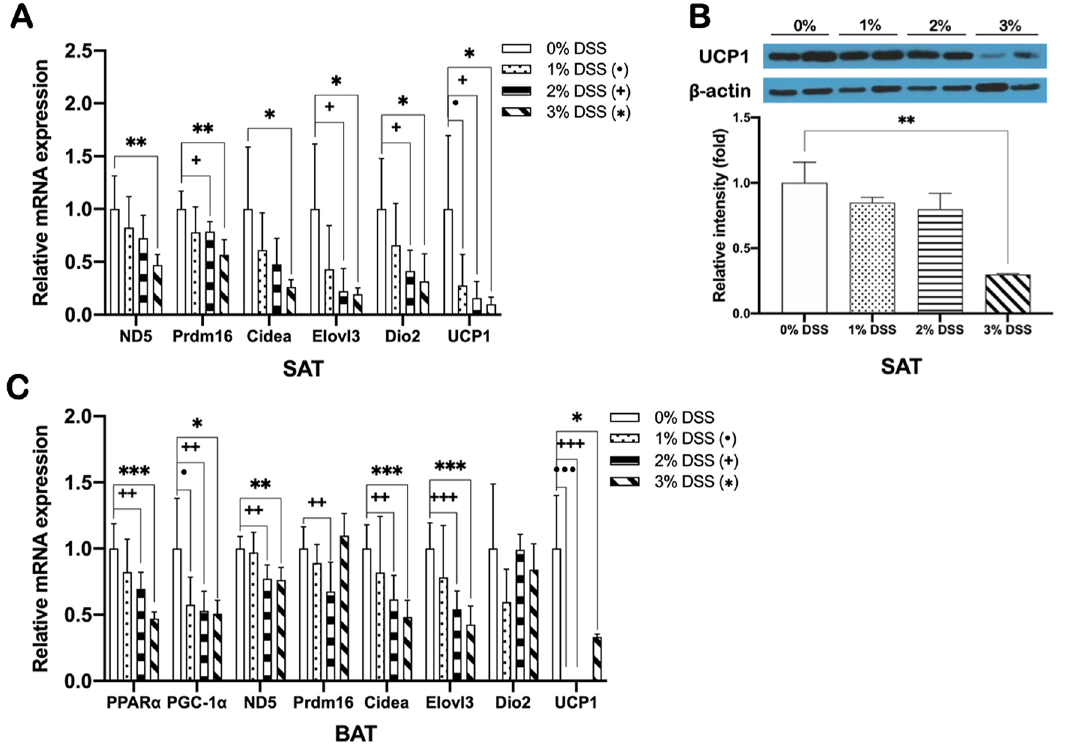
Figure 5. DSS-induced colitis suppresses the expression of genes involved in SAT browning and BAT thermogenesis. mRNA expression of ( A ) browning genes in SAT and ( C ) thermogenic genes in BAT, and protein expression of ( B ) UCP1 in SAT of DSS-induced colitis and non-colitis mice. Gene expression levels are normalized to GAPDH expression. Data present mean ± SD for 5–8 mice in each group. Student’s two- tailed t-test was used for the analysis of differences between experimental groups. •,+, * p < 0.05, ••,++, ** p < 0.01, •••,+++, *** p <